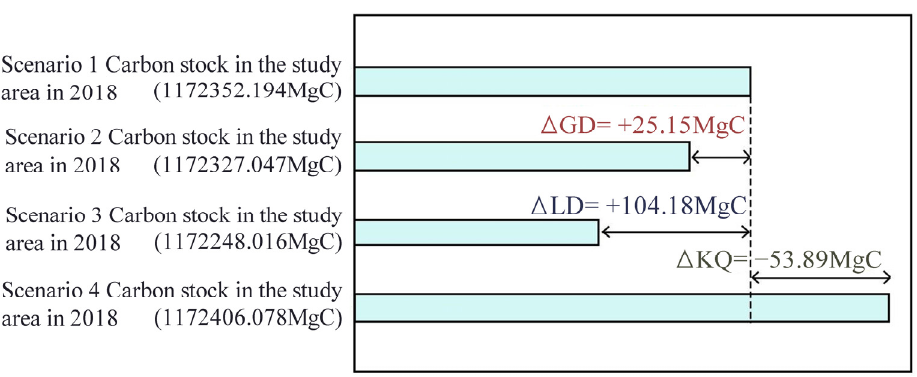
Figure 7. Effects of cropland change (GD), forest land change (LD), and ecological restoration of mining areas (KQ).